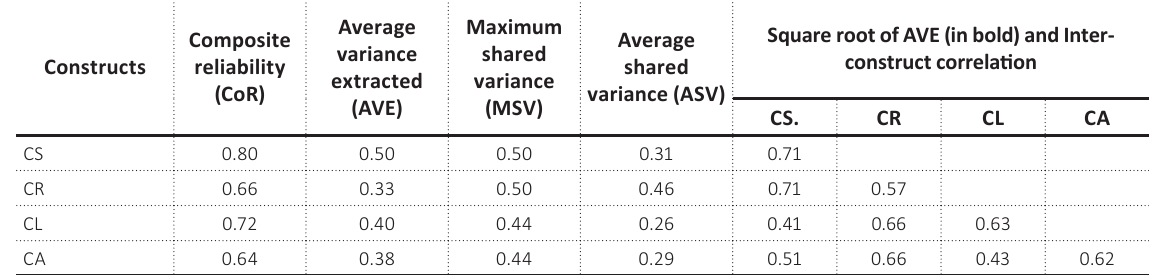
Table 3. Validity